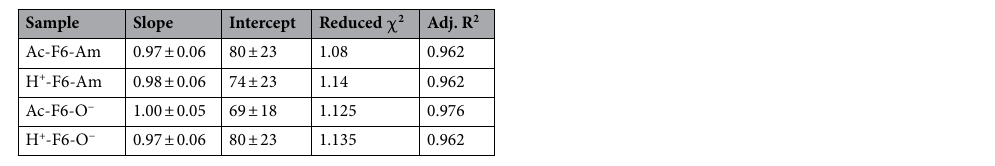
Table 1. Summary of the estimated quantities of the linear fits reported in Fig. 3c together with their relevant statistic parameters.